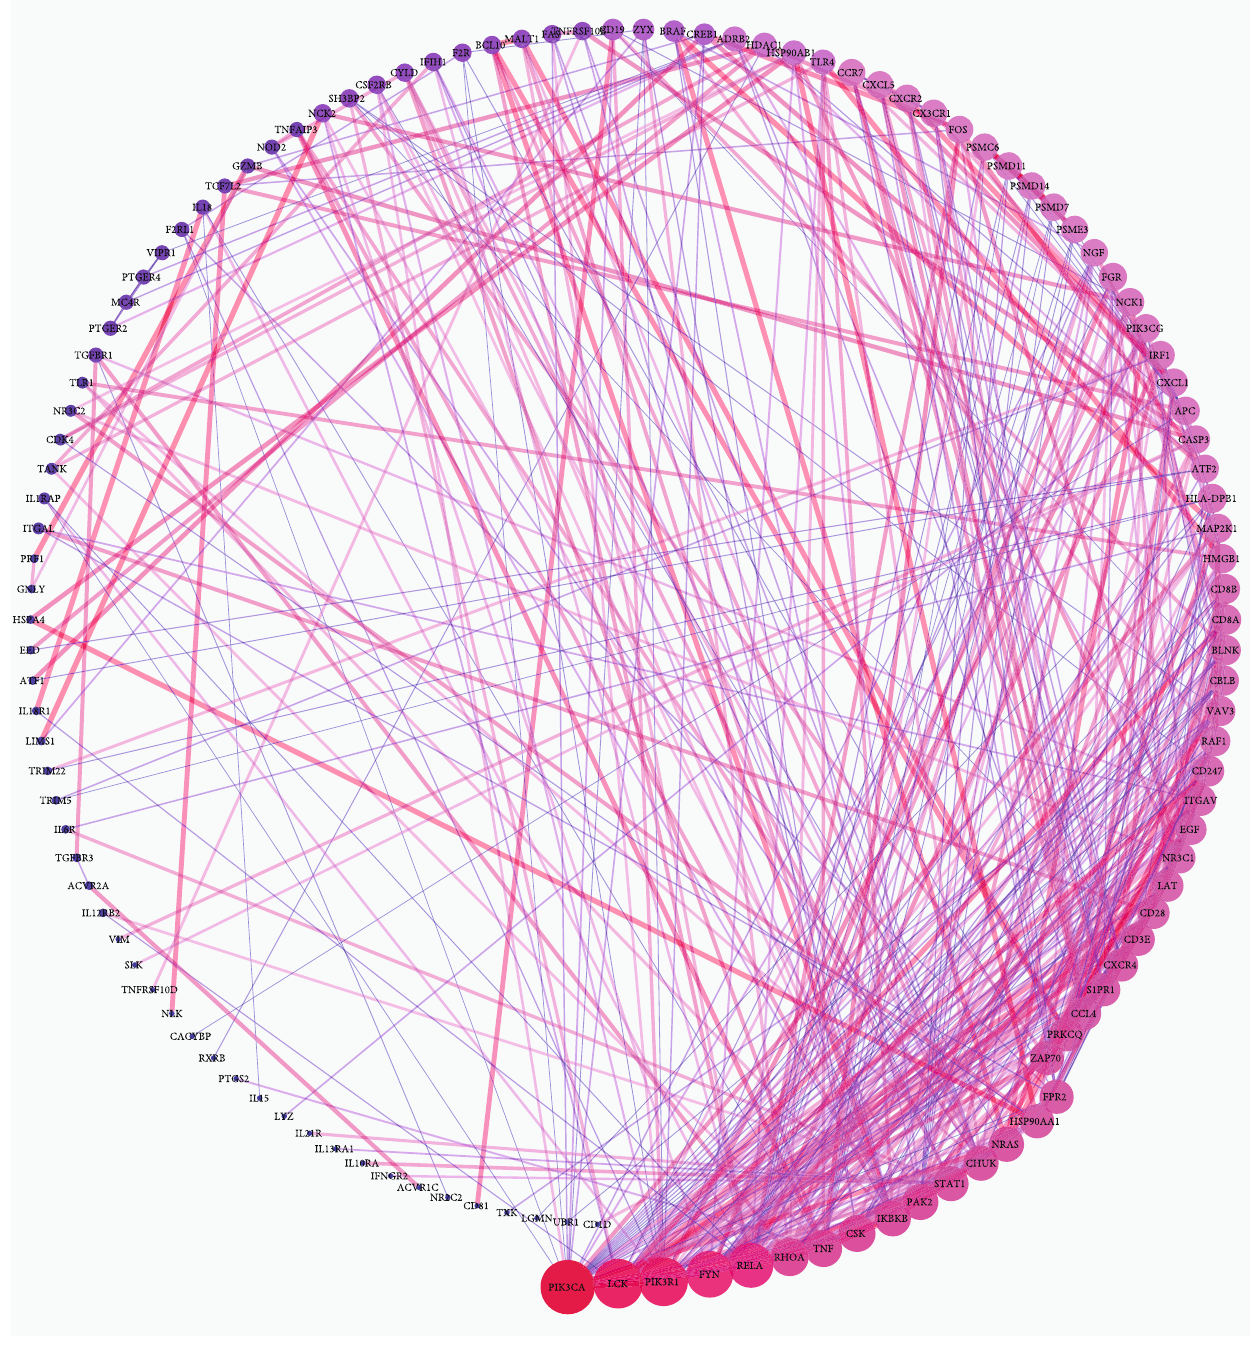
Figure 6: The exploration of PPI with 178 target genes using String. The area of the circle is proportional to the size of the